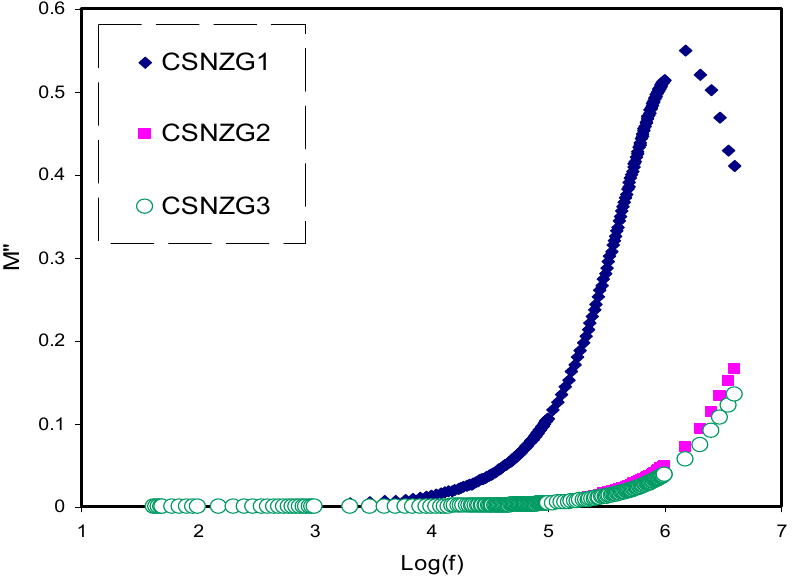
Figure 8. Variation of M ” along with frequency for the CSNZG1, CSNZG2, and CSNZG3 composite electrolyte samples at ambient temperature.